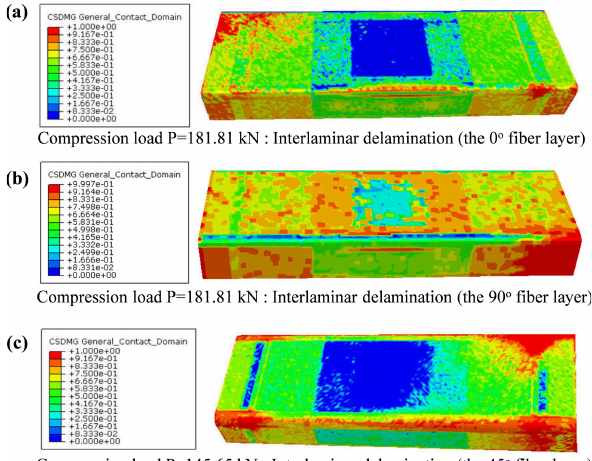
Figure 16: Interlaminar delamination failure area distribution of the compression columns at the ultimate bearing state: (a) DCYG-A: 0 ∘ fiber layer, (b) DCYG-A: 90 ∘ fiber layer, and (c) DCYG-B: 45 ∘ fiber layer.